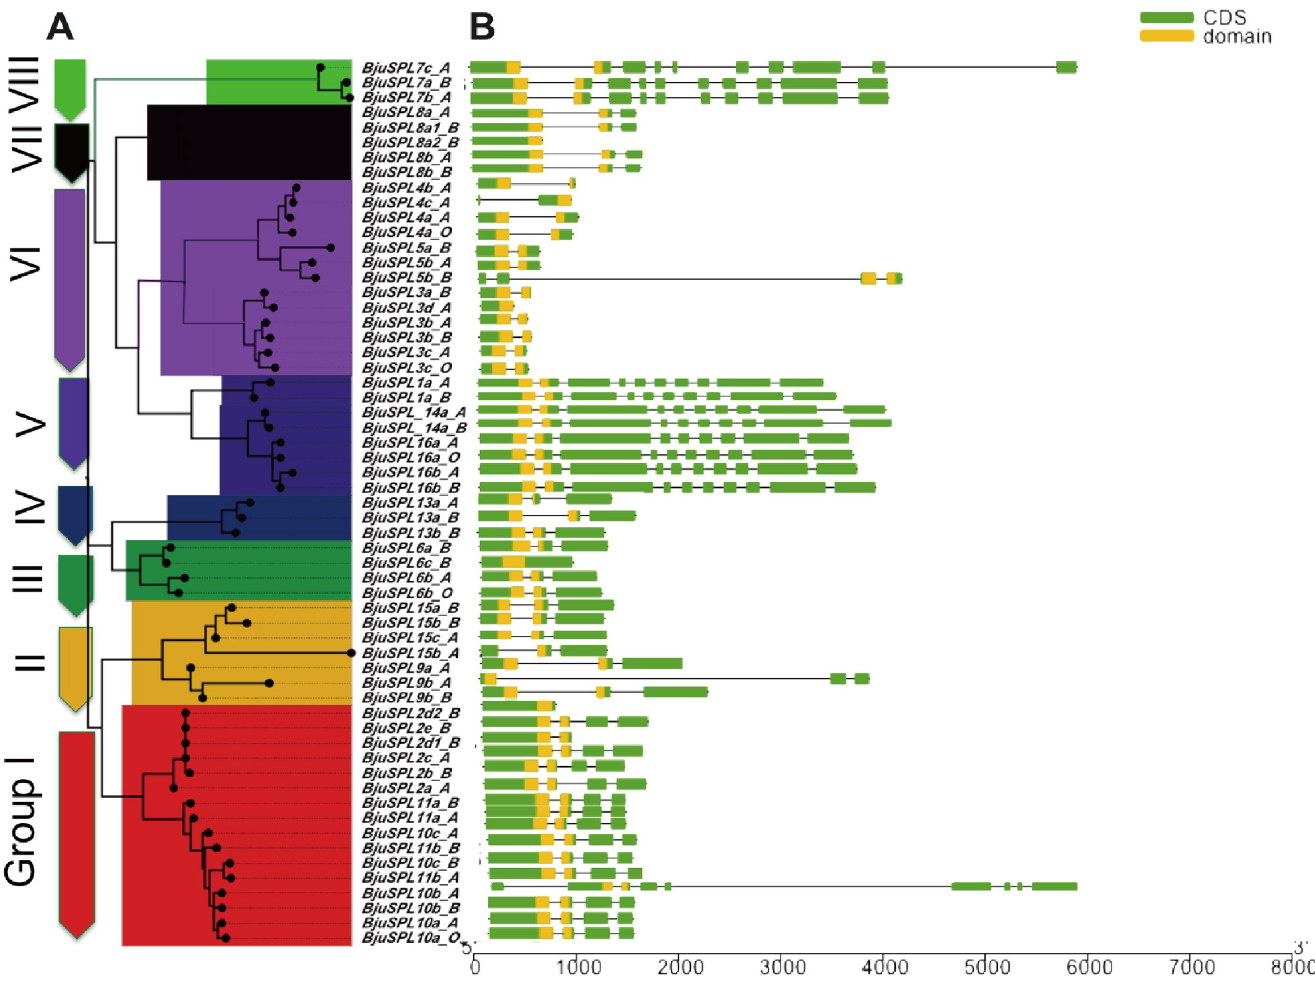
Fig 3. Phylogenetic tree of the SPL genes and genomic organization of SPL genes in B . juncea . A: The SBP domain was identified and the phylogenetic tree was constructed using MEGA7, and the maximum likelihood method with 1000 bootstraps. Different groups of the SBP family are divided with different colors. B: Exon/ intron structures of B . juncea SPL genes. Untranslated 5 0 and 3 0 regions and CDS are shown in gray and black. Black lines connecting two CDS represent introns.